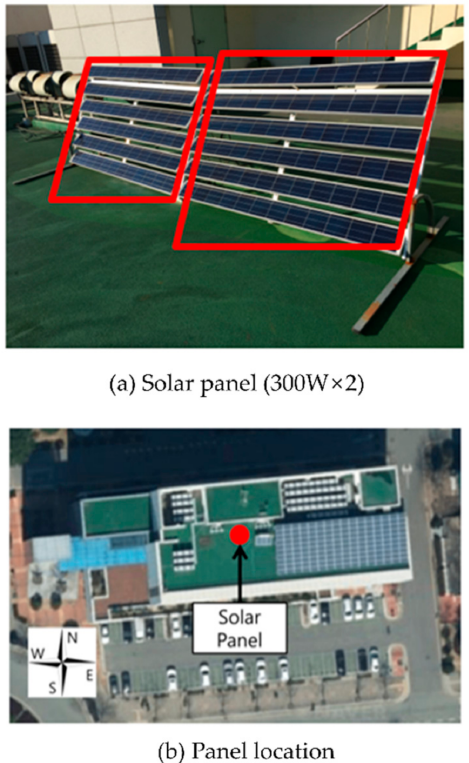
Figure 8. Solar panel and location. ( a ) is the Solar panel used in the experiment. ( b ) is Panel location.